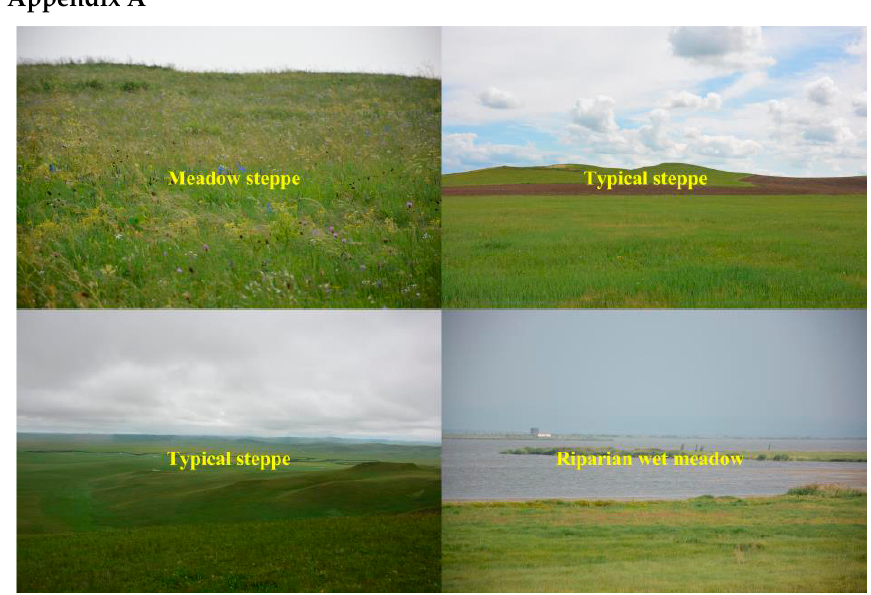
Figure A1. Photographs of the main types of ecosystems taken over the Wulagai River Basin in July